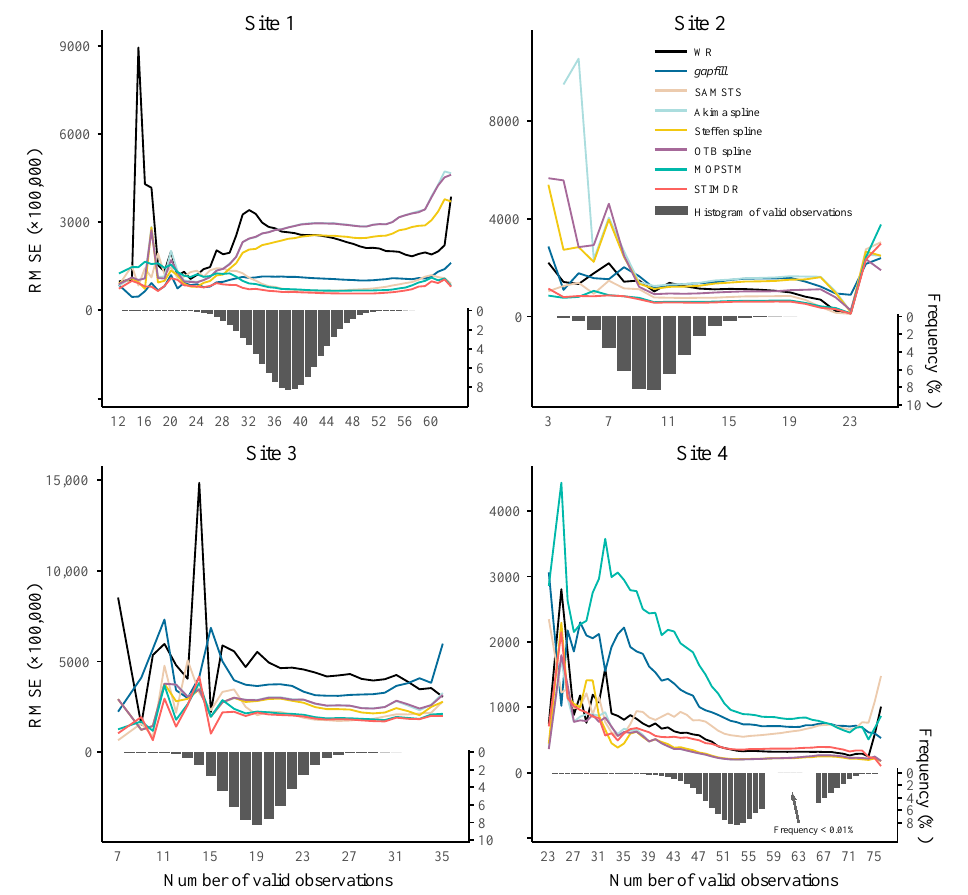
Figure 8. Dependence of median RMSE on the number of observations in every pixel location throughout the 5-year